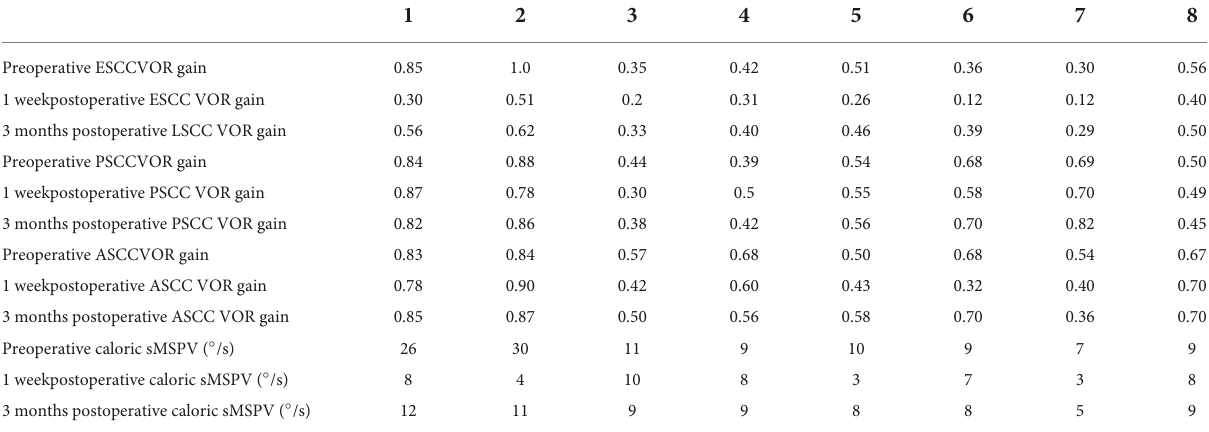
TABLE 9 Pre- and postoperative vestibular function examinations of type II labyrinthine fistula patients in group 2.